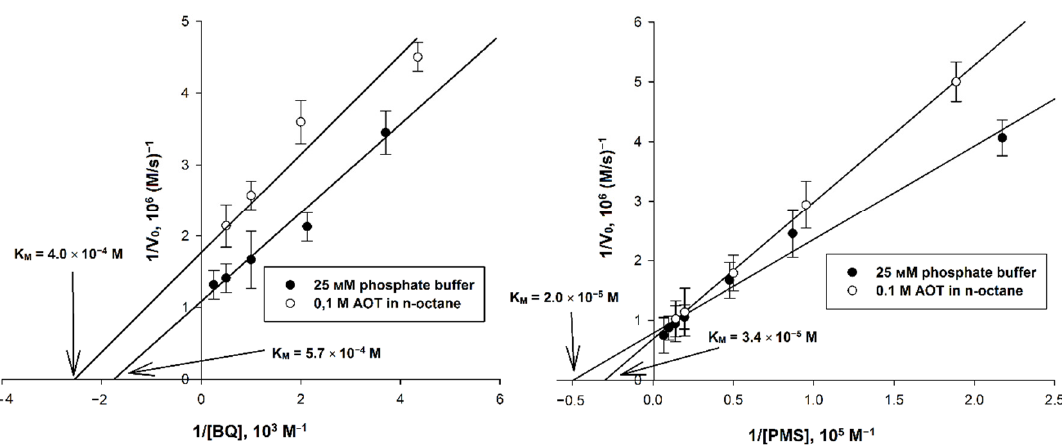
Figure 3. Double reciprocal plots for systems using 1,4-benzoquinone and phenazine methosulfate (with varying EA concentration), for which media with pH 7.8 and 8.8 were used, respectively. The concentrations of AtGALDH and and L -galactone-1,4-lactone were 6 × 10 − 9 M and 1 mM, respectively. Values are presented as the mean ± SD of three experiments.